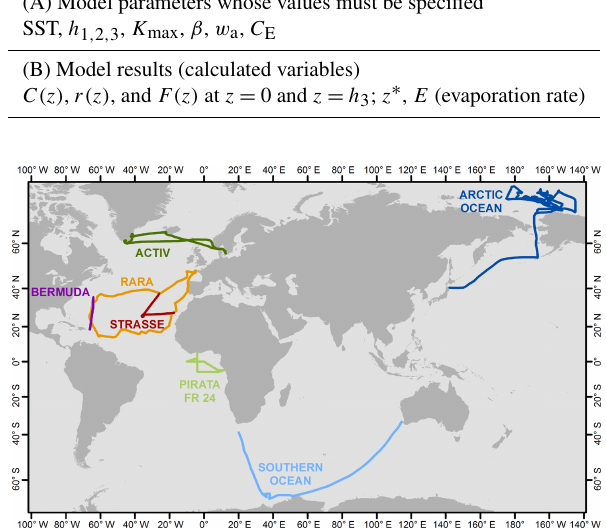
Figure 2. Map showing the tracks for seven cruises that generated vapor isotopic observations used in this work. Information about each cruise is listed in Table 3 and the associated